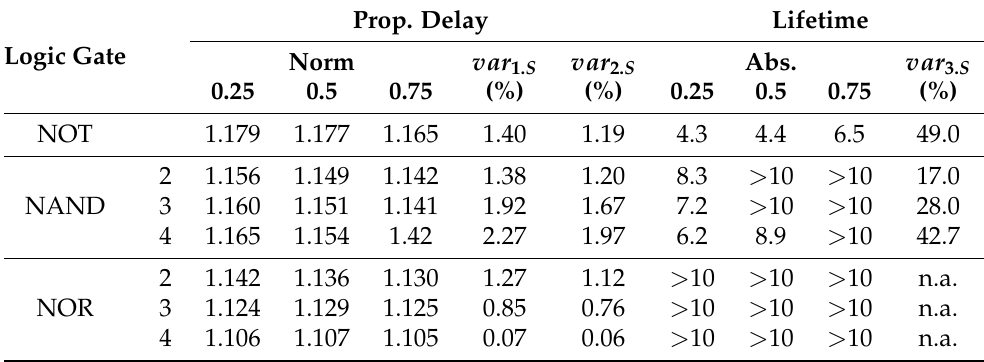
Figure 5. Normalized propagation delay for different input signal probabilities for basic gates (operating temperature T = 75 ◦ C; NF : normalization factor): ( a ) 2-in NAND ( NF = 8.08 ps); ( b ) 3-in NAND ( NF = 11.98 ps); ( c ) 4-in NAND ( NF = 16.62 ps); ( d ) 2-in NOR ( NF = 11.29 ps); ( e ) 3-in NOR ( NF = 19.93 ps); ( f ) 4-in NOR ( NF = 30.17 ps). Table 4. Input probability induced variability in the propagation delay and